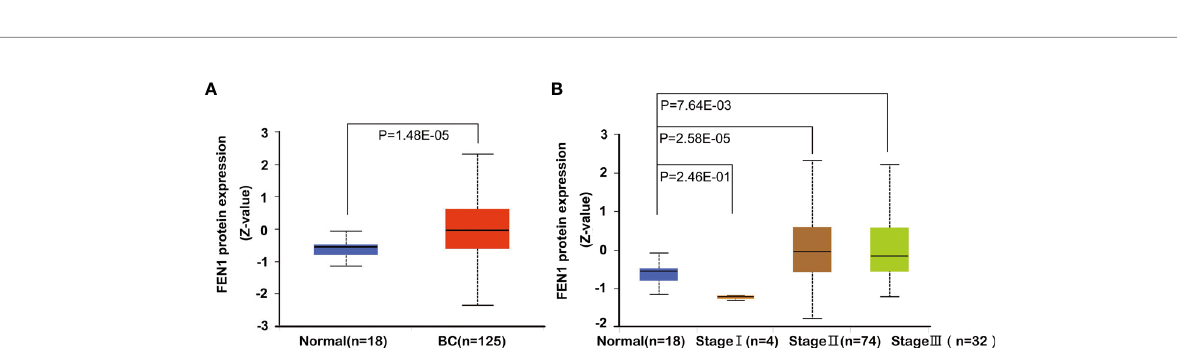
FIGURE 1 | Oncomine database analysis revealing upregulated FEN1 mRNA expression in BC compared with the normal controls. (A – D) The FEN1 mRNA levels were signi fi cantly higher in BC than in controls according to the Curtis Breast Statistics, TCGA Breast Statistics, and Richardson Breast 2 Statistics datasets.